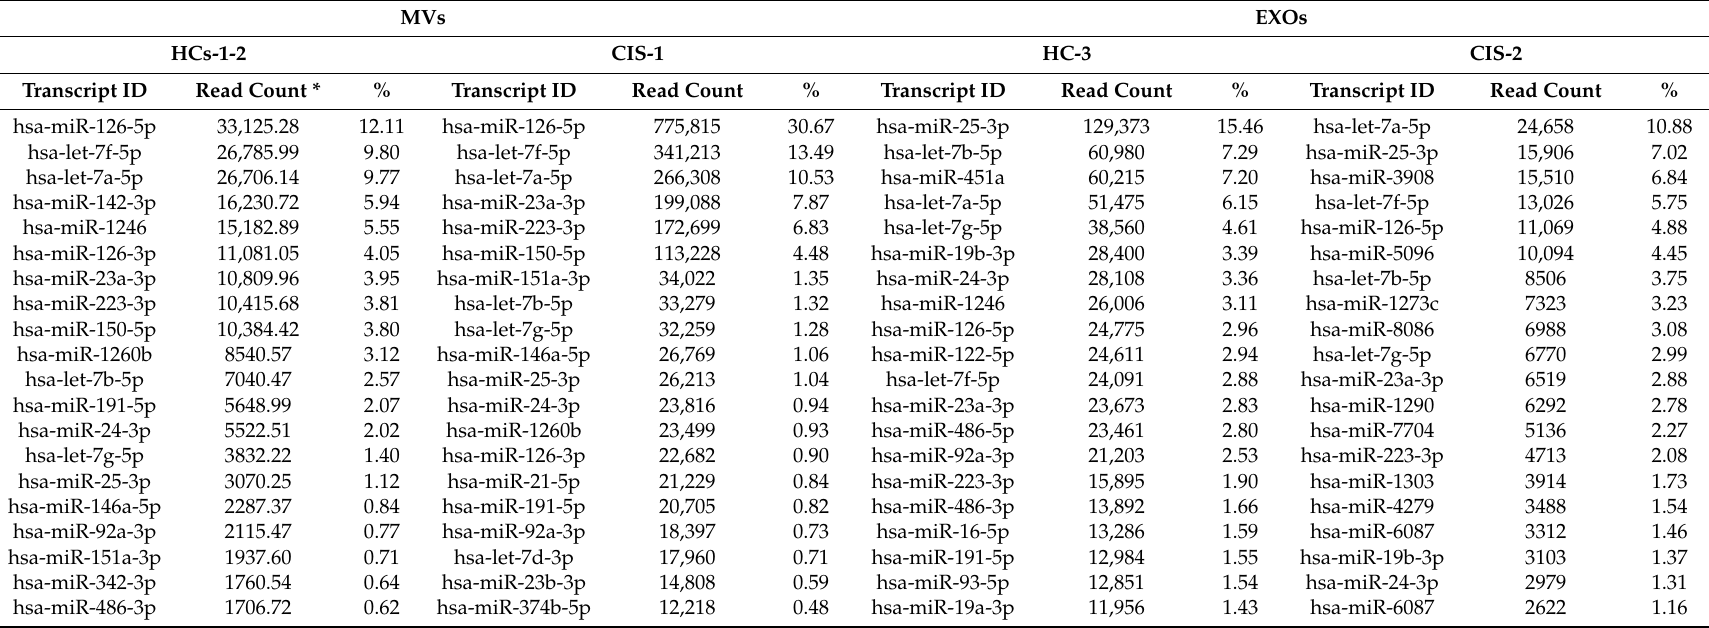
Table 2. The 20 most abundant miRNAs in MVs and EXOs samples, accounting for 74.68% (in MVs-HC), 86.82% (MVs-CIS), 77.18% EXOs-HC) and 71.45% (EXOs-CIS) of all detectable miRNAs. In bold, nine miRNAs that are in common in all EV